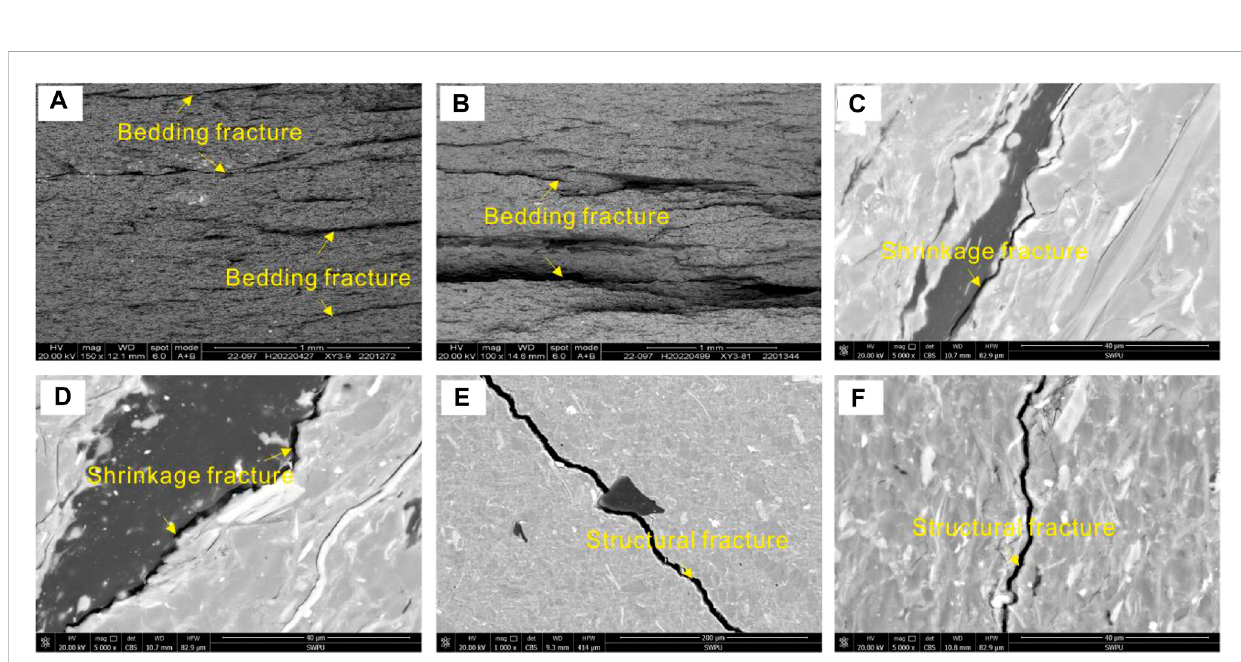
FIGURE 4 High-resolutionSEMimageofmicrofracturesinLianggaoshanFormationlacustrineshalereservoir. (A) Multiplebeddingfractureareparalleltoeach other, Type A shale,Well C, 2455.06 m; (B) Bedding fracture in Type A shale,Well B, 1896.13 m; (C) Shrinkage fracture between organic matter and clay mineral, Type B shale,Well C, 2452.29 m; (D) Shrinkage fracture between organic matter and clay mineral, Type B shale,Well A, 1751.71 m; (E) Structural fracture in Type C shale, Well C, 2465.48 m; (F) Structural fracture in Type C shale, Well B, 1928.58